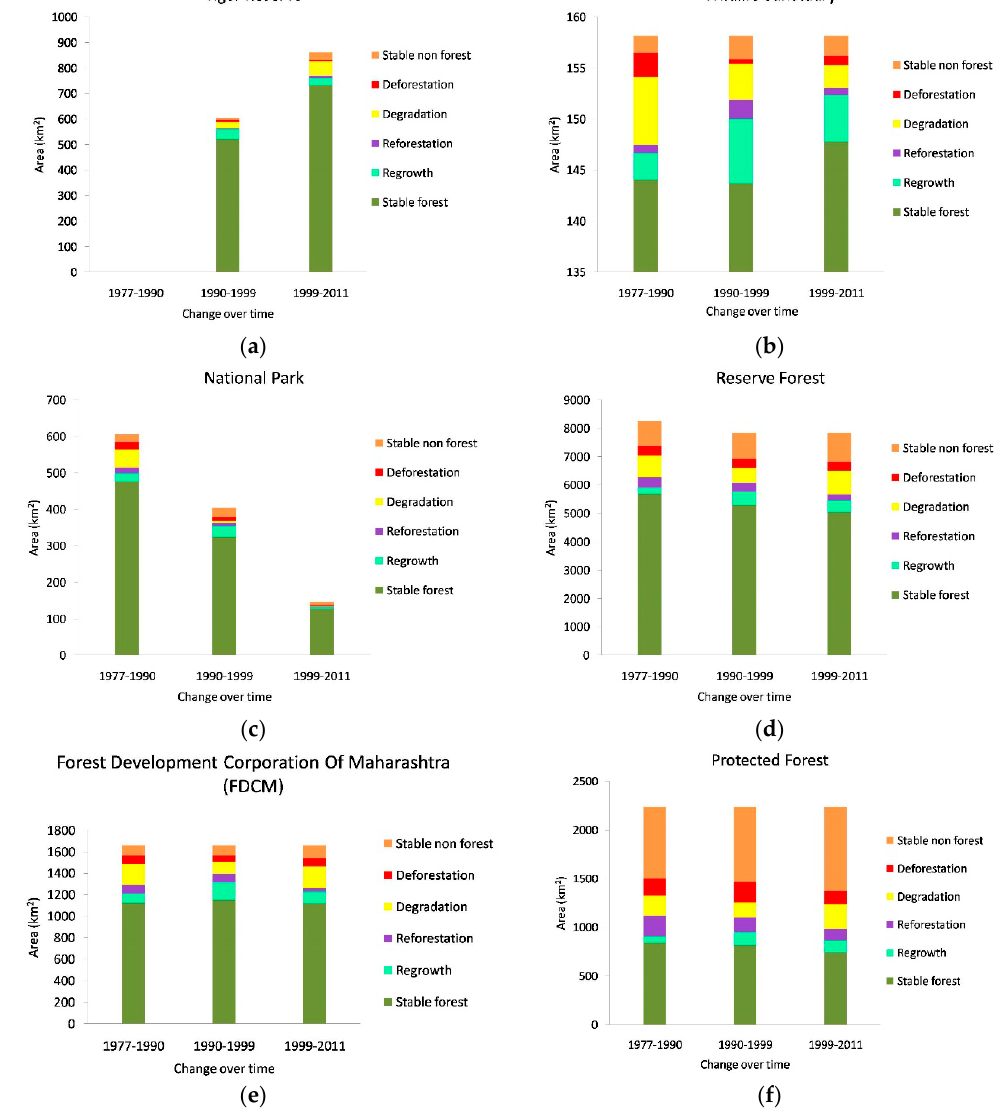
Figure 3. Change in area and land cover classes inside ( a ) Tiger Reserve; ( b ) Wildlife Sanctuary; ( c ) National Park; ( d ) Reserve Forest; ( e ) Forest Development Corporation of Maharashtra (FDCM); ( f ) Protected Forest over time.